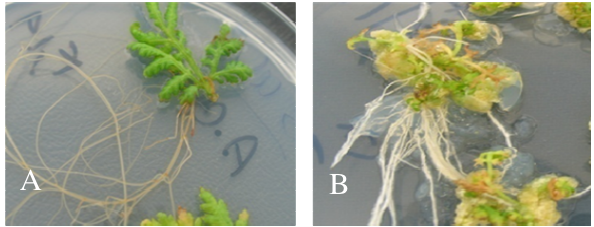
Fig. 5. The longest induced roots at 0.5 mg/l NAA + sucrose (A), and 2 mg/l NAA + sucrose (B) with leaf explants of A. annua